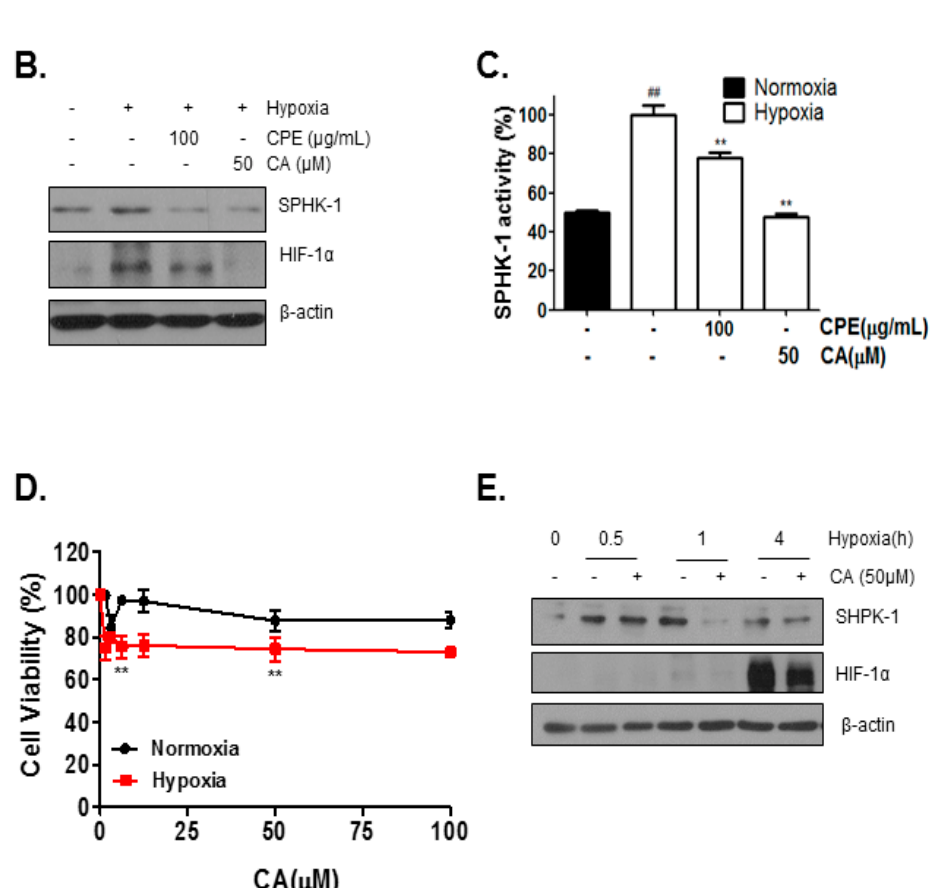
Figure 2. Effect of CA on hypoxia-induced SPHK-1 and HIF-1 α expression and SPHK-1 activity in DU145 cells. ( A ) Upper graph: HPLC chromatograms of CPE. Lower graph: Standard peak of CA (39.172 min); ( B ) Effect of CA on hypoxia-induced SPHK-1 and HIF-1 α expression; ( C ) Inhibitory effect of CA on hypoxia-induced SPHK-1 activity assay. Data are presented as means ± S.D. (**) p < 0.01 compared to control under hypoxia. (##) p < 0.01, compared to control under normoxia; ( D ) Effects of CA on the cytotoxicity of DU145 cells for 24 h under normoxic and hypoxic condition. Data are presented as means ± S.D. (**) p < 0.01 compared to control; ( E ) Change of SPHK-1 and HIF-1 α expression by hypoxic exposure time.